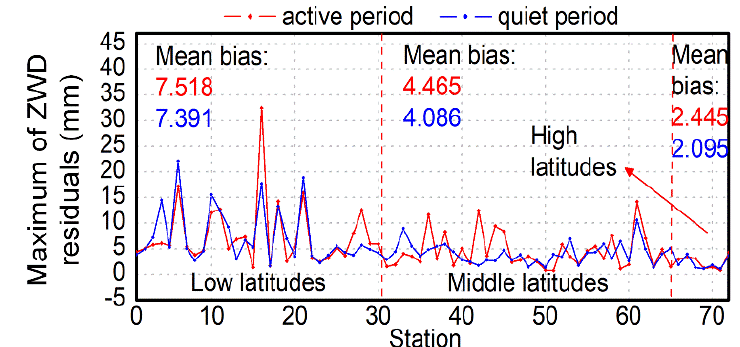
Figure 10. The statistics of the effect of HOI on ZWD in different geomagnetic situations (active period: DOY 250–252 in 2017; quiet period: DOY 241–243 in 2017). The mean biases of ZWD estimation differences in different ionospheric conditions are shown in the figure. Stations at different latitudes are separated by red dashed lines.